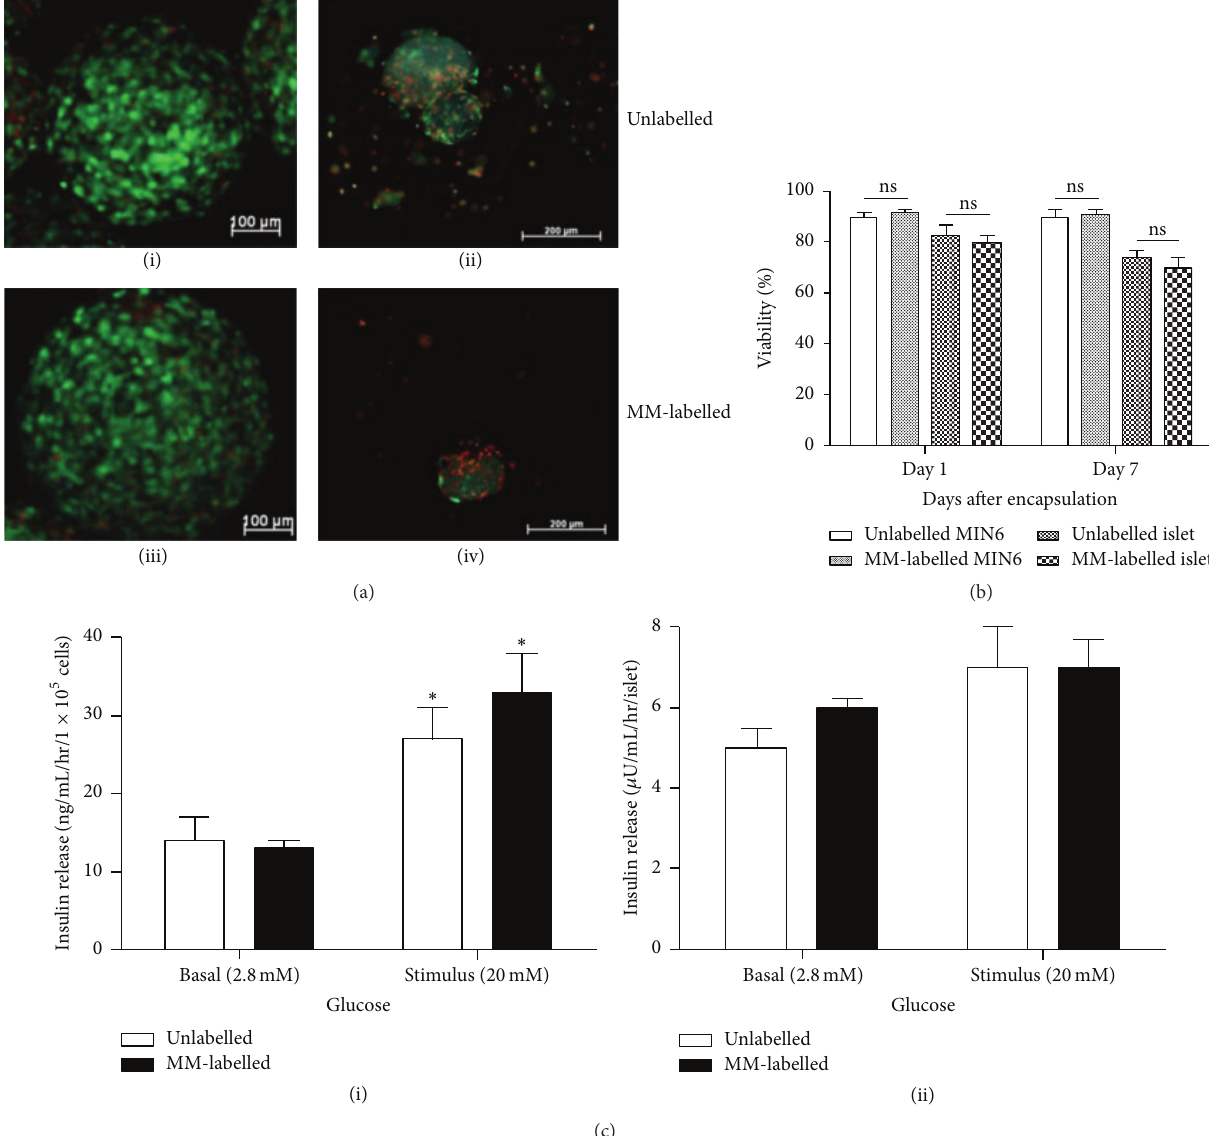
Figure 3: Viability and insulin secretion of encapsulated MM-labelled cells. (a) Viability images of unlabelled and MM-labelled encapsulated MIN6 (i and iii) and human islets (ii and iv), respectively. Bar is 100 𝜇 m for (i) and (iii) and 200 𝜇 m for (ii) and (iv), respectively. (b) Viability of encapsulated MM-labelled cells cultured for varied time points after encapsulation. Values are mean ± SEM ( 𝑛 = 100 capsules for each time point); ns, 𝑝 > 0.05 for viabilities between unlabelled and MM-labelled MIN6 and human islets at each time point (Student’s t -test). (c) Glucose stimulated insulin secretion of both MM-labelled MIN6 (i) and human islets (ii) 24 hr after encapsulation. Values are mean ± SEM ( 𝑛 = 3 ); ∗ 𝑝 < 0.05 for basal versus stimulated insulin secretion for encapsulated unlabelled and MM-labelled MIN6, respectively (Student’s t